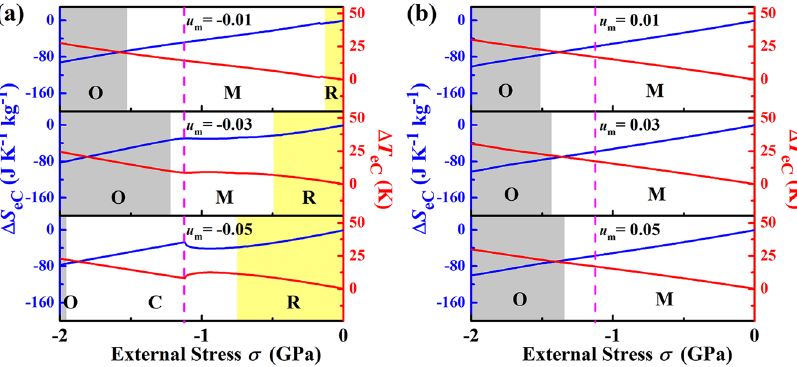
Fig. 3 The eC performance of the [MDABCO](NH4)I3 thin fi lm as a function of external stress and substrate mis fi t strain. The eC entropy change Δ S eC with a compressive mis fi t strains and b tensile mis fi t strains. The gray, white, and yellow regions mark different phases. The blue line shows the entropy change, while the red line indicates the temperature change. The pink dash line marks the maximum nonuniform directional stress − 1.28 GPa above which the system undergoes plastic deformation.